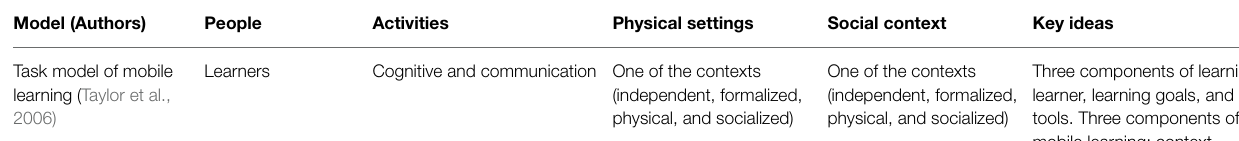
TABLE 1 | A comparison of models relevant to online distance learning in higher education